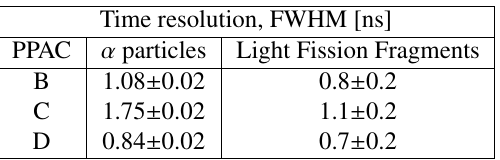
Table 1. Results for the time resolution of the di ↵ erent PPACs with ↵ particles and light fission